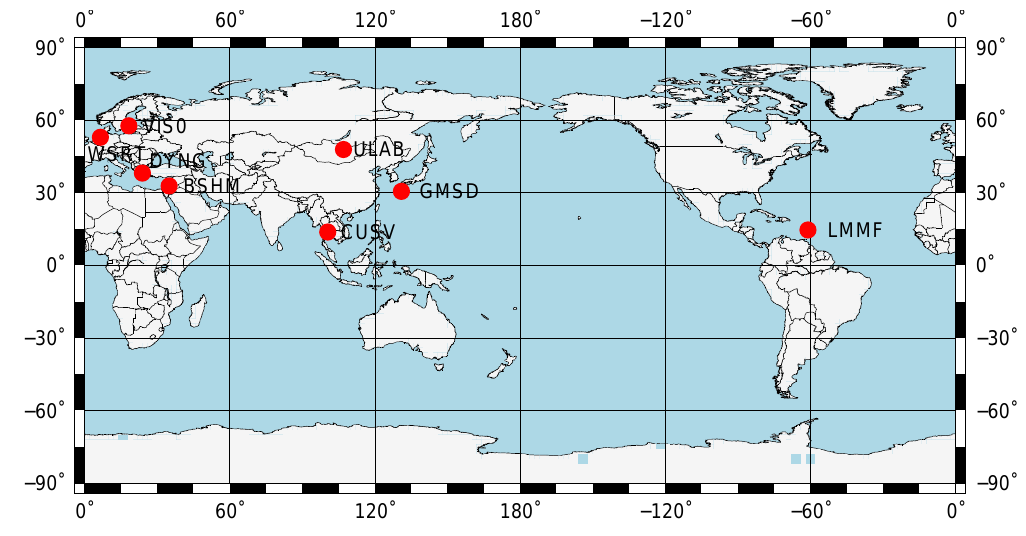
Figure 12. Station distribution in the real-time PPP.